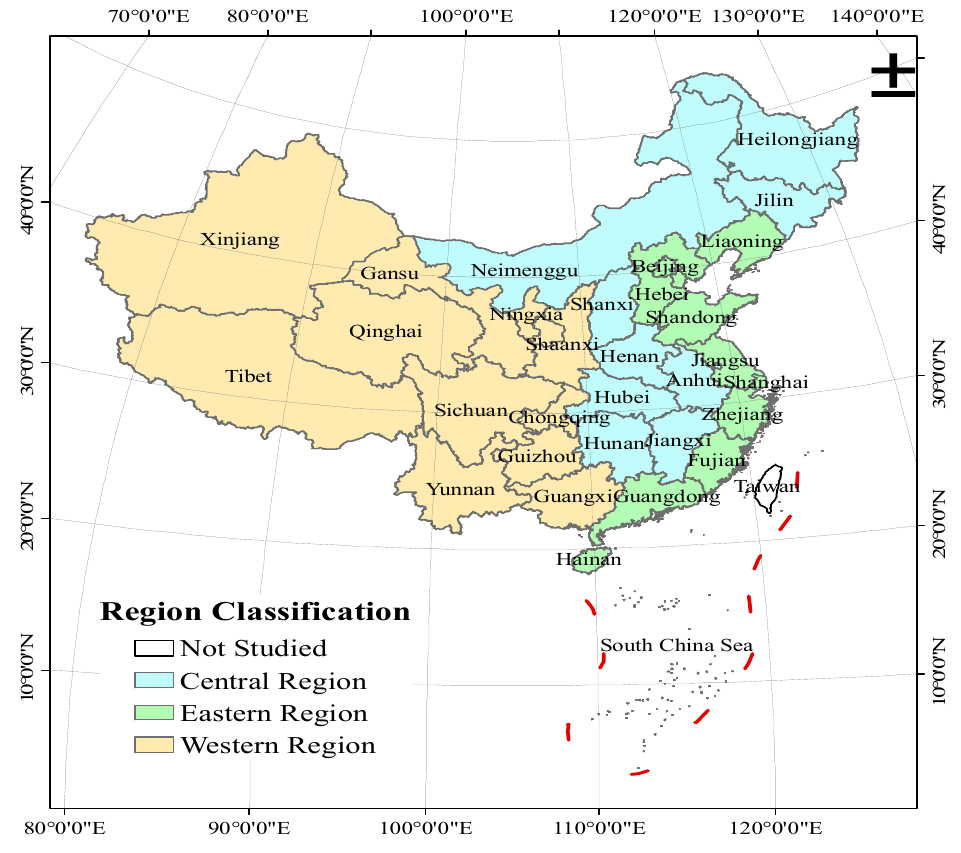
Figure 1. The study area overview map.